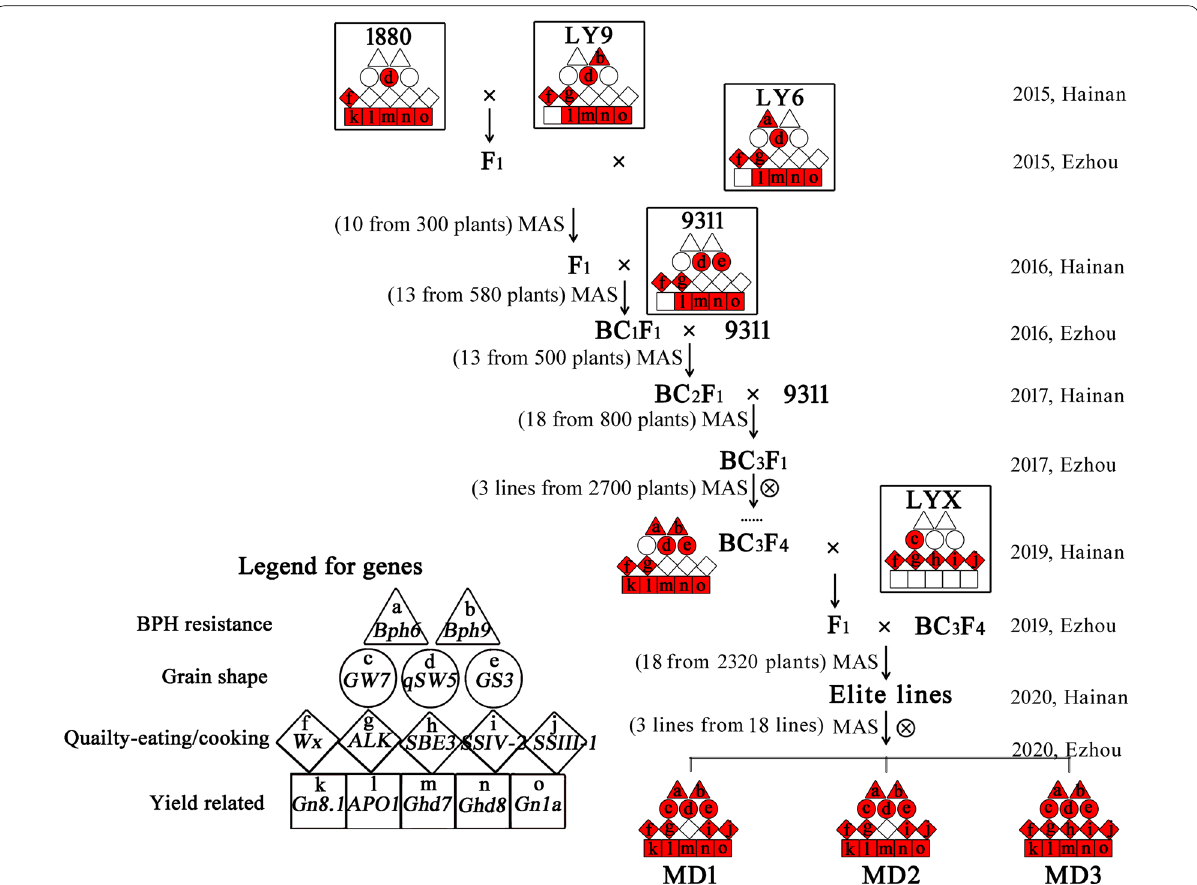
Fig. 2 Schematic diagram of molecular design breeding process. The square represents yield-related genes, Gn8.1 (k), APO1 (l), Ghd7 (m), Ghd8 (n) and Gn1a (o); diamond represents eating and cooking quality related genes, Wx (f), ALK (g), SBE3 (h), SSIV-2 (i) and SSIII-1 (j); circle represents grain shape related genes, GW7 (c), qSW5 (d) and GS3 (e); triangle represents rice BPH resistance related genes, Bph6 (a) and Bph9 (b). The red fill represents the functional allelic fragments, and no color represents non-functional allelic